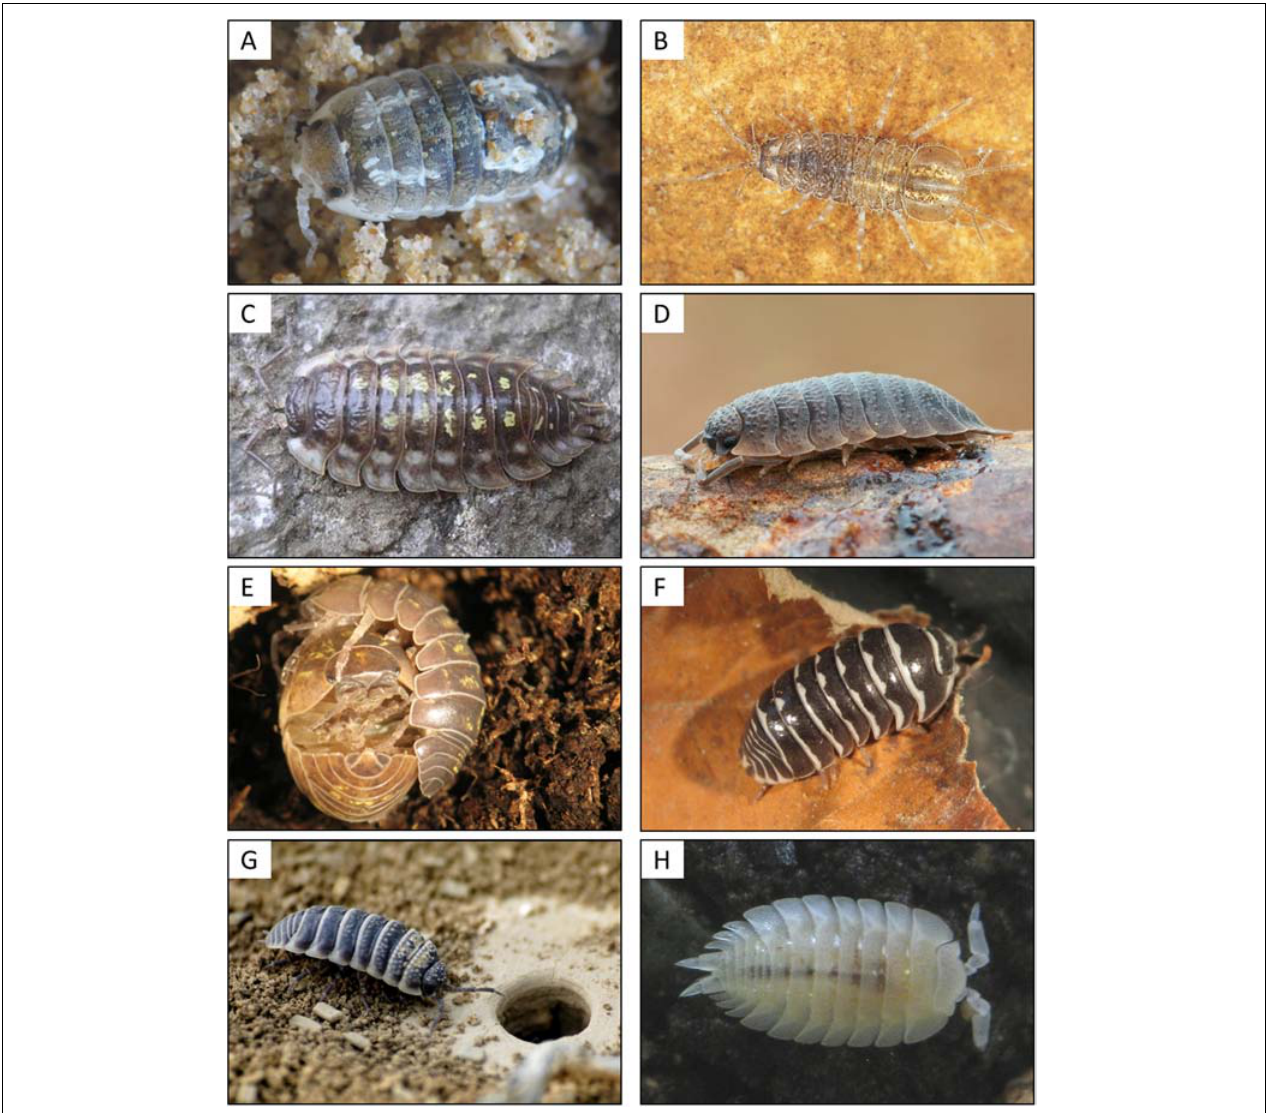
FIGURE 1 | Diversity of terrestrial isopods from littoral to desert habitats. (A) The semi-terrestrial Tylos europaeus , inhabiting the littoral zone; (B) the freshwater isopod Asellus aquaticus ; (C) the common woodlouse Oniscus asellus ; (D) the rough woodlouse Porcellio scaber ; (E) the pillbug Armadillidum vulgare during mating; (F) the “zebra pillbug” Armadillidium maculatum ; (G) the desert isopod Hemilepistus reaumuri near the entrance of a burrow in Tunisia; and (H) the ant woodlouse Platyarthrus hoffmannseggii . This species is blind and lives in ant nests. Picture credit: Martin Zimmer (B) , Sören Franzenburg (D) , Giuseppe Montesanto (G) , UMR CNRS 7267 (A,C,E,F,H)